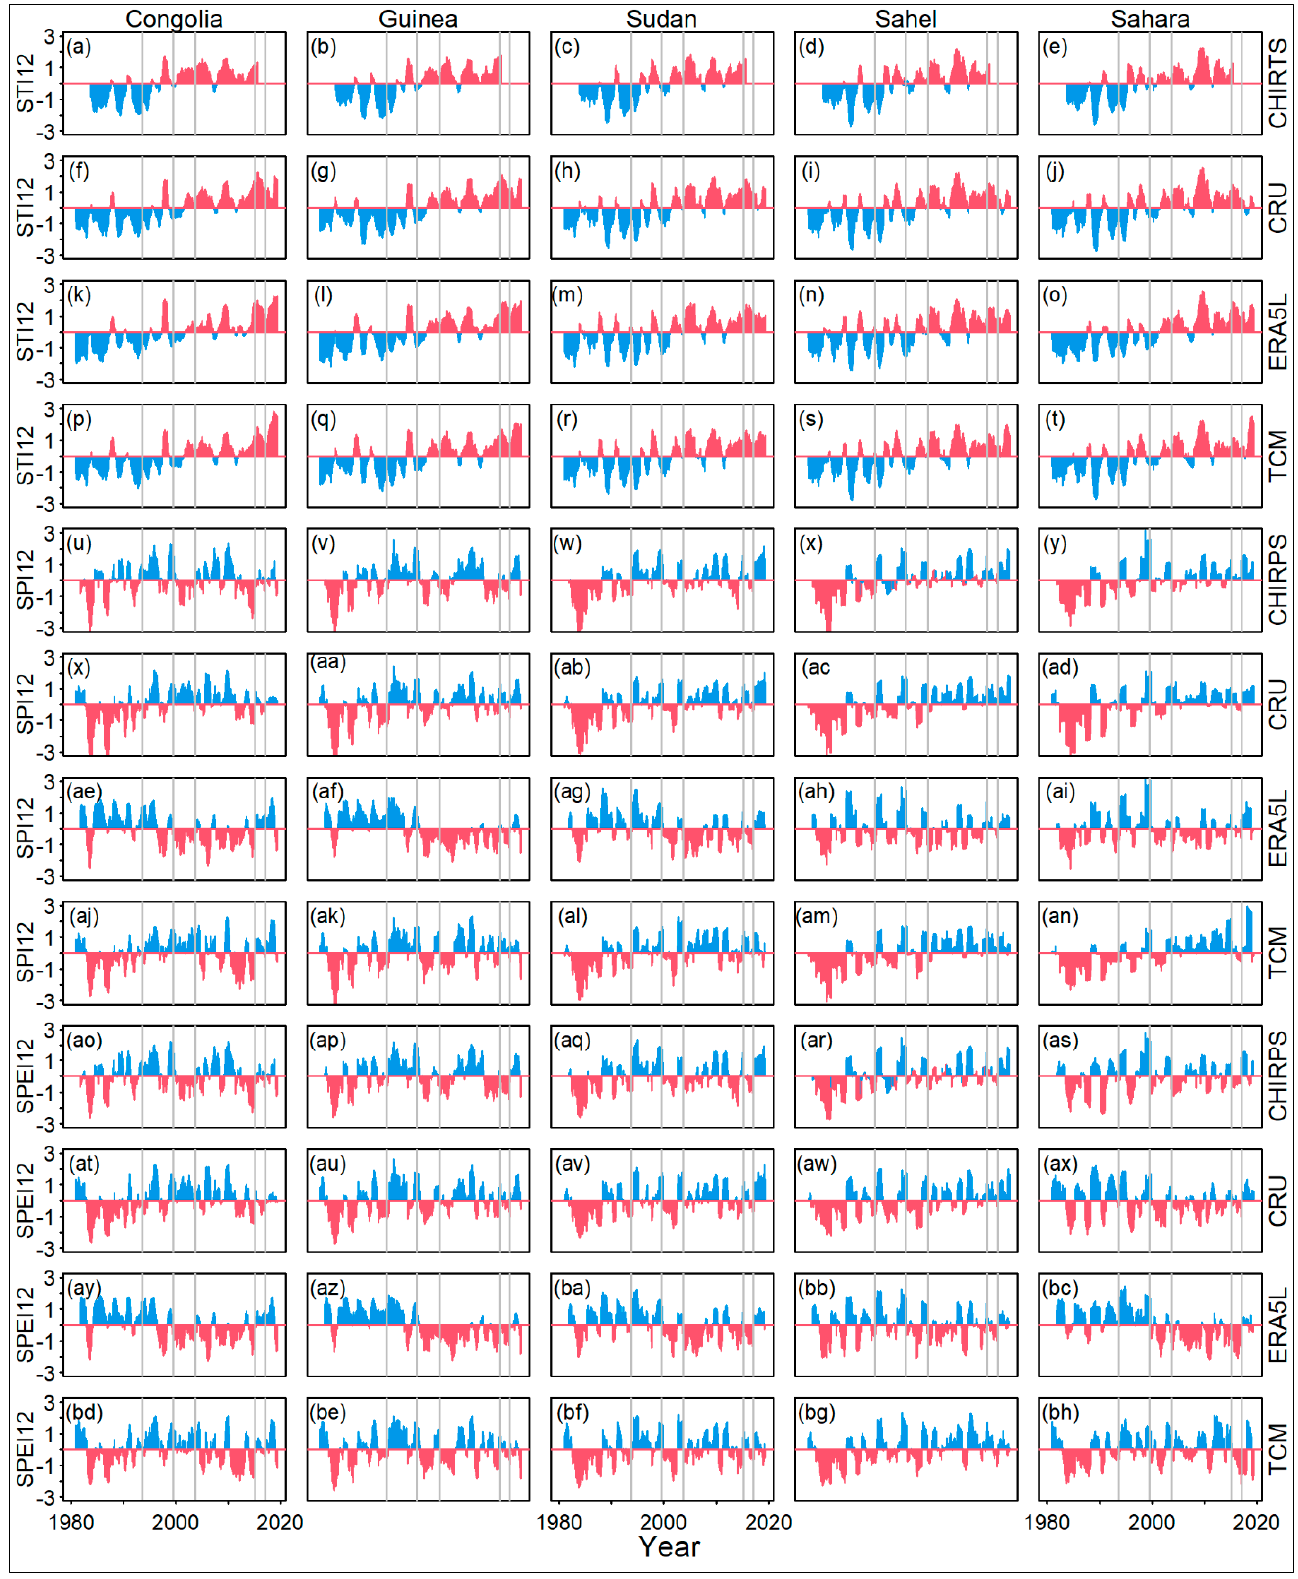
Figure 7. Climatic indices showing years with spikes in land cover area (grey lines) in West Africa. The vertical lines (in grey) are the years for which abrupt land cover changes (Figure 7) have been experienced. The STI values of the CHIRTS, CRU, ERA5-Land, and TerraCli- mate datasets show the climate of West Africa from 1980 to 2020 may be divided into two